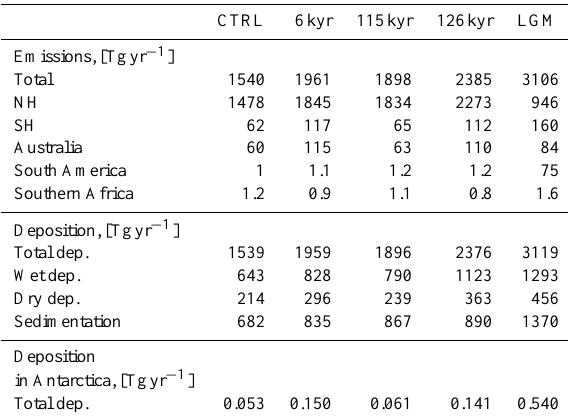
Table 2. Global mass budget for different climate conditions. CTRL